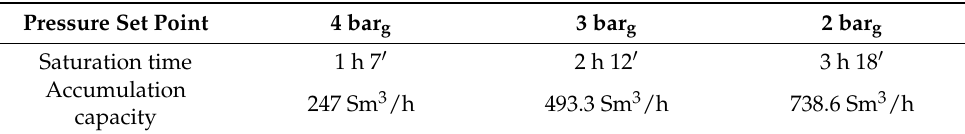
Table 4. Network accumulation capacity of biomethane generated with the decreasing of the pressure set point for each pressure level analyzed and related saturation time of the network under the case of complete injection of